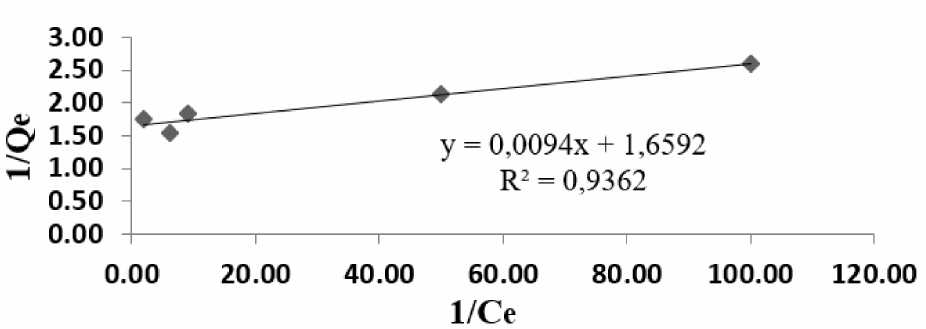
Figure 8. Langmuir model for the adsorption of lead ions from